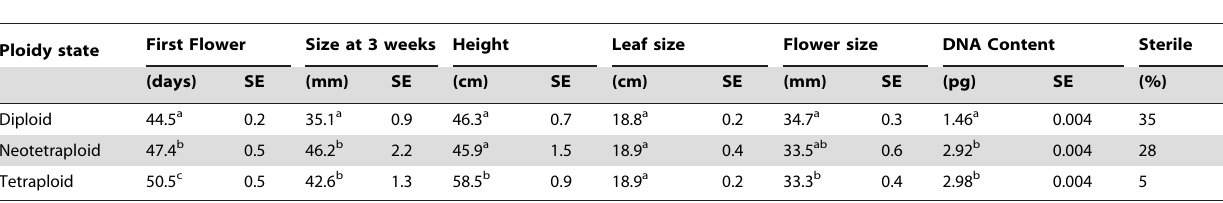
Letters indicate significant differences at p=0.05 or less between ploidies according to Tukey’s HSD.